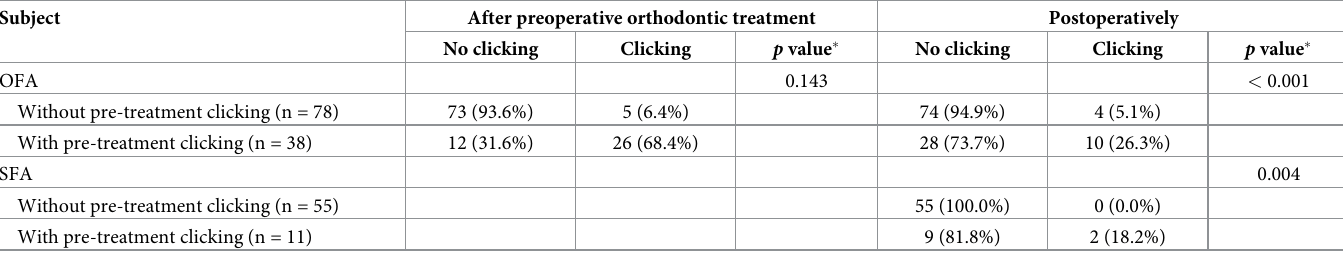
Table 2. Changes of TMJ clicking according to the approaches in surgical-orthodontic treatment.